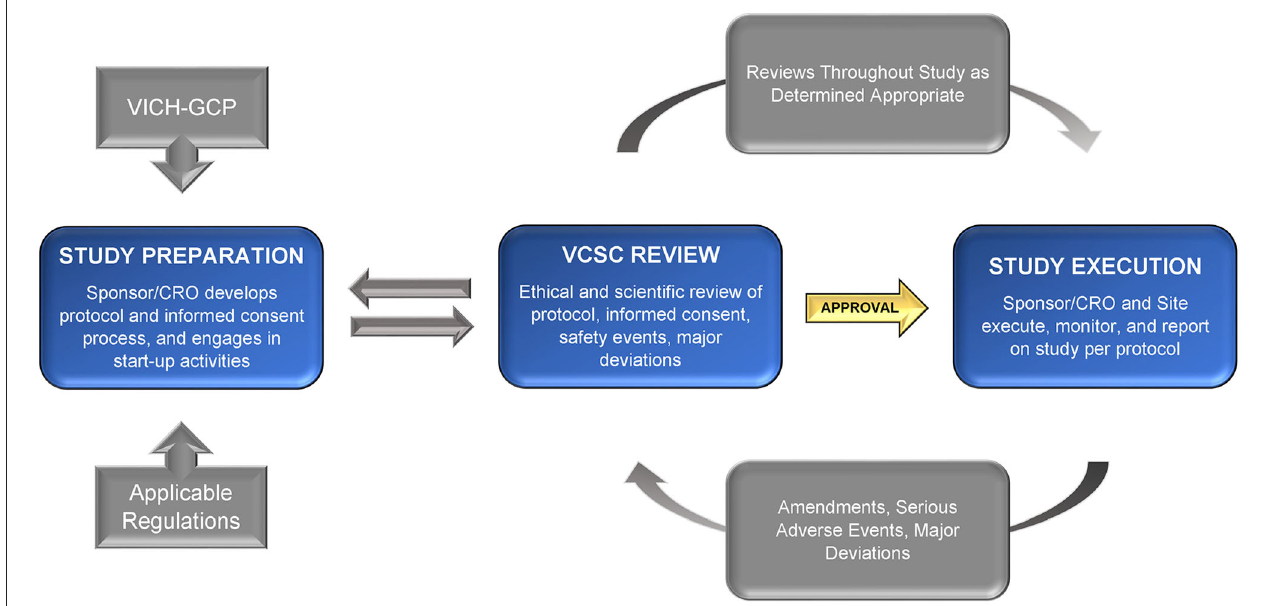
FIGURE 1 | Flowchart: ethical review process for veterinary clinical